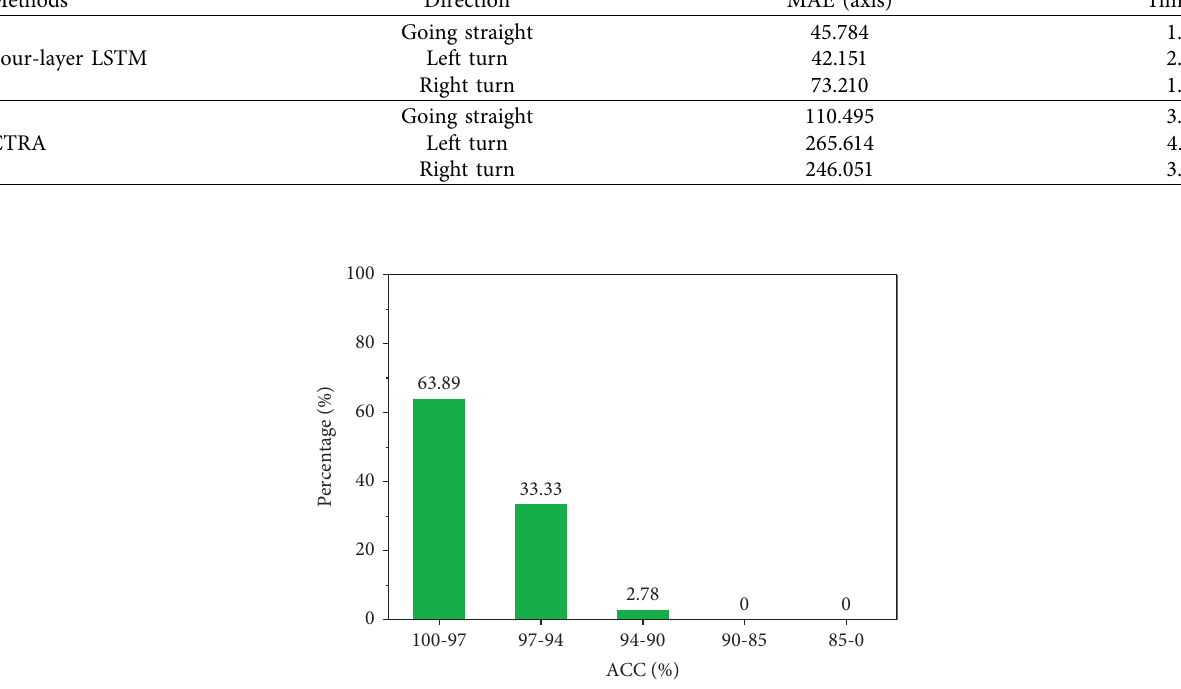
Figure 11: Training accuracy distribution for going